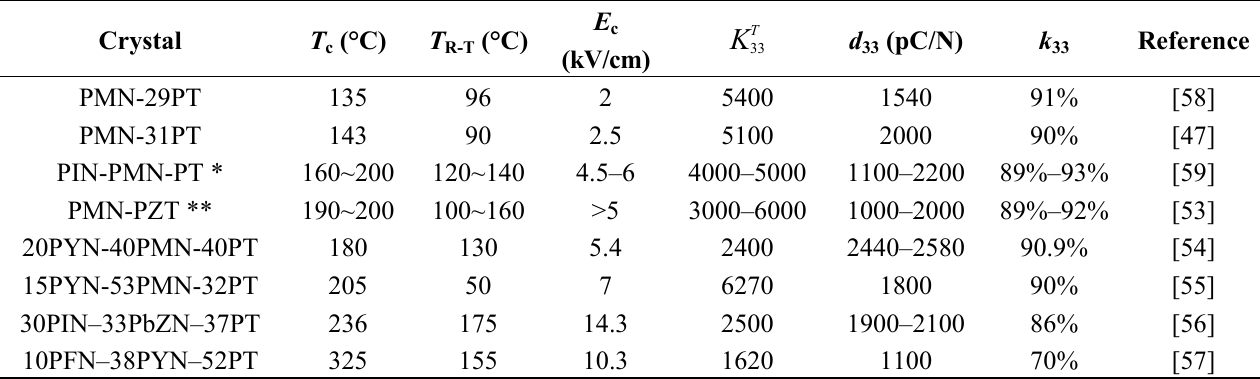
Table 3. Detailed dielectric and piezoelectric properties of PMN-PT-based ternary crystals.